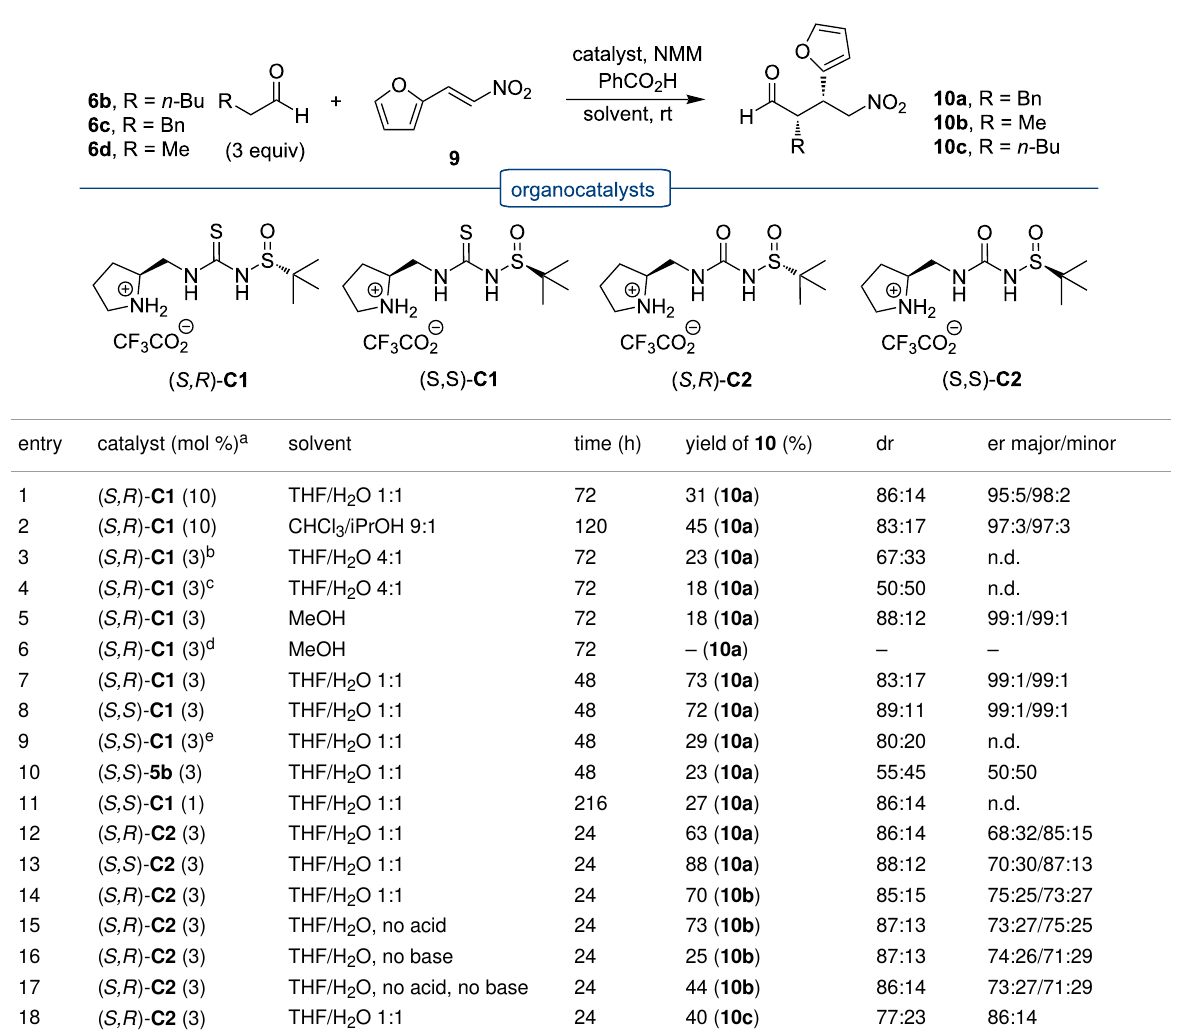
Table 1: Michael additions of aldehydes 6b – d with nitroalkene 9